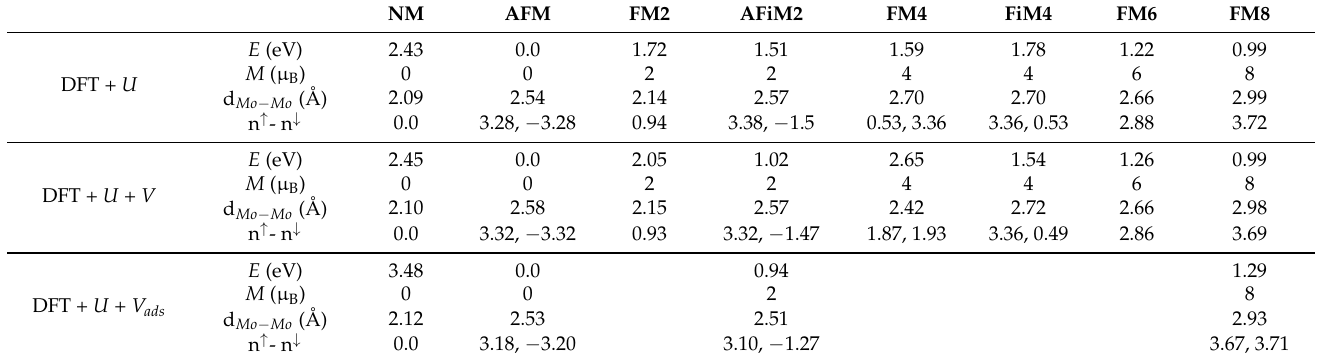
Table 3. DFT+Hubbard results for the MoMo molecule in the gas-phase and as adsorbed on calcite (10.4). DFT + U + V ads indicates calculations for MoMo adsorbed on calcite, performed only on lowest-energy magnetic